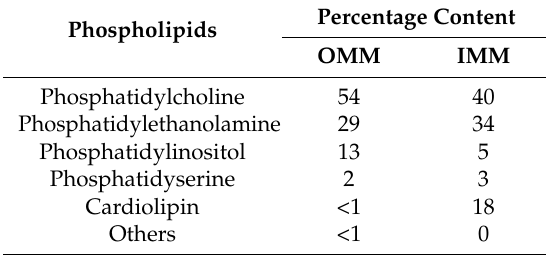
Table 1. Percentage content of different phospholipid classes in mammalian mitochondria